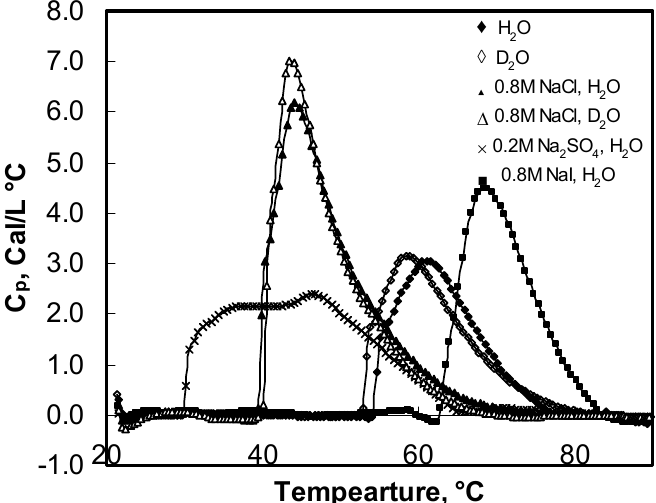
Figure 1. Differential scanning calorimetry (DSC) scans showing Cp plots for HPMC O and D O with various solutions in H 2 2